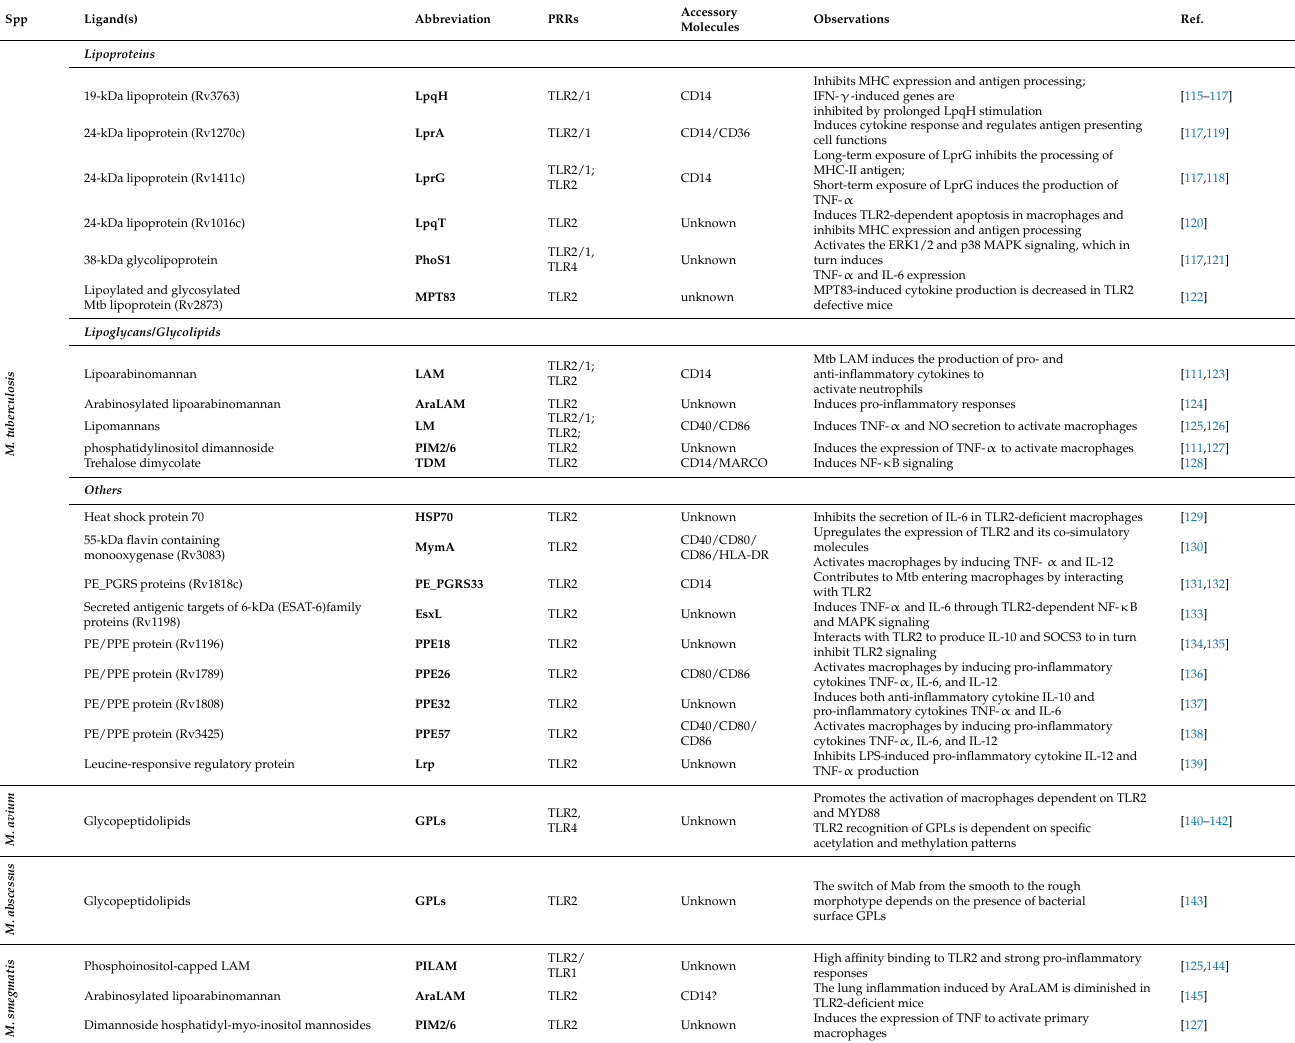
Table 1. Mycobacterial ligands of